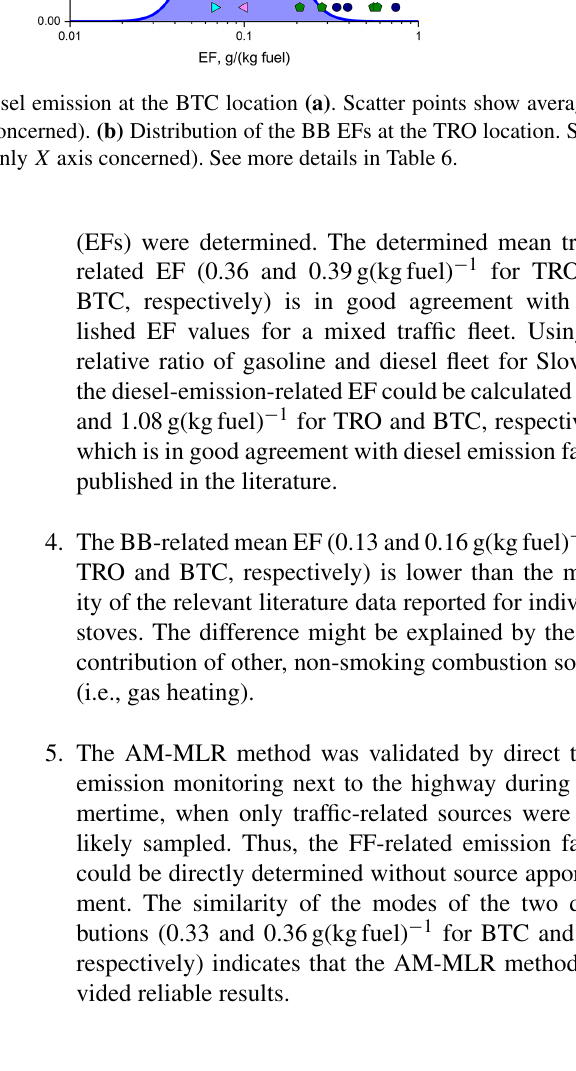
wood burning during the winter heating season. The